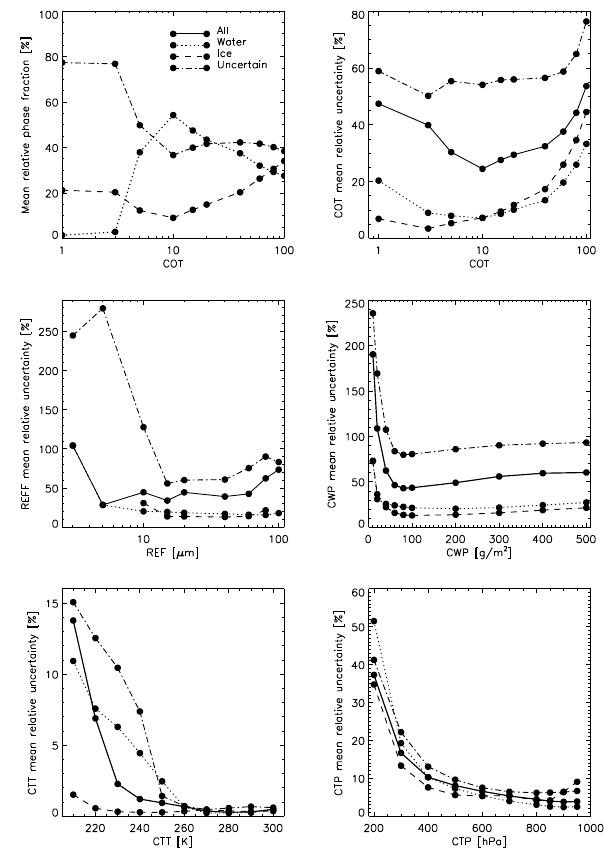
Figure 6. Histograms of the mean relative phase fraction and mean relative uncertainty estimates for FAME-C cloud properties cloud optical thickness (COT), effective radius (REF), cloud water path (CWP), cloud top temperature (CTT) and cloud top pressure (CTP) for all successfully retrieved cloudy pixels (converged and cost < 20) for orbit segments covering the region in Germany between lat. 9 and 14 ◦ and long. 49 and 54 ◦ (presented in Fig. 5 as GER) for the years 2007–2009. Results are shown separately for the three cloud phases – water, ice and uncertain – and for all cloudy